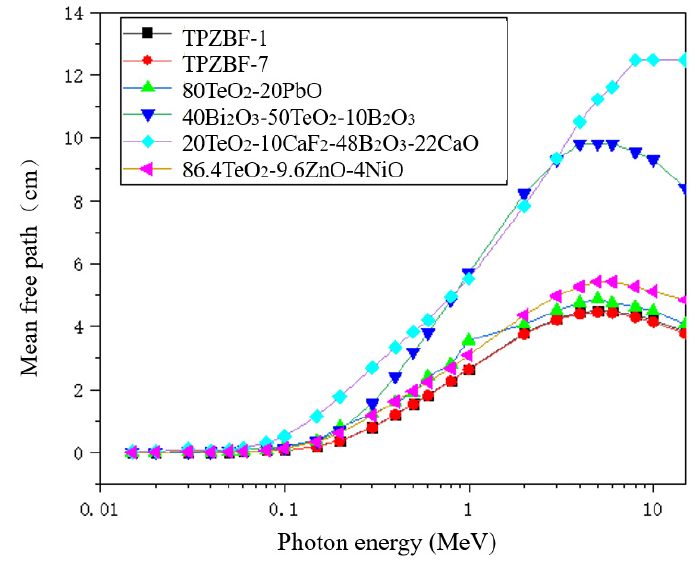
Figure 6. The relationship between MFP value and photon energy and BaF 2 content. Figure 6. The relationship between HVL value and photon energy and BaF 2 content. The effective atomic number Z eff of TPZBF glass obtained by theoretical calculation, as shown in Figure 7, Z eff is another critical factor in materials science and radiation physics, and it is an indispensable parameter in the study of gamma shielding. The Z eff value reveals the radiation-proof ability of the material against gamma-ray attenuation when photons pass through the material. It is easier to intercept via collision with a large Z eff atomic nucleus. They are highly attenuated in these materials. The high Z eff value of the radiation-proof ability of glass shields against gamma radiation is better in practical shielding